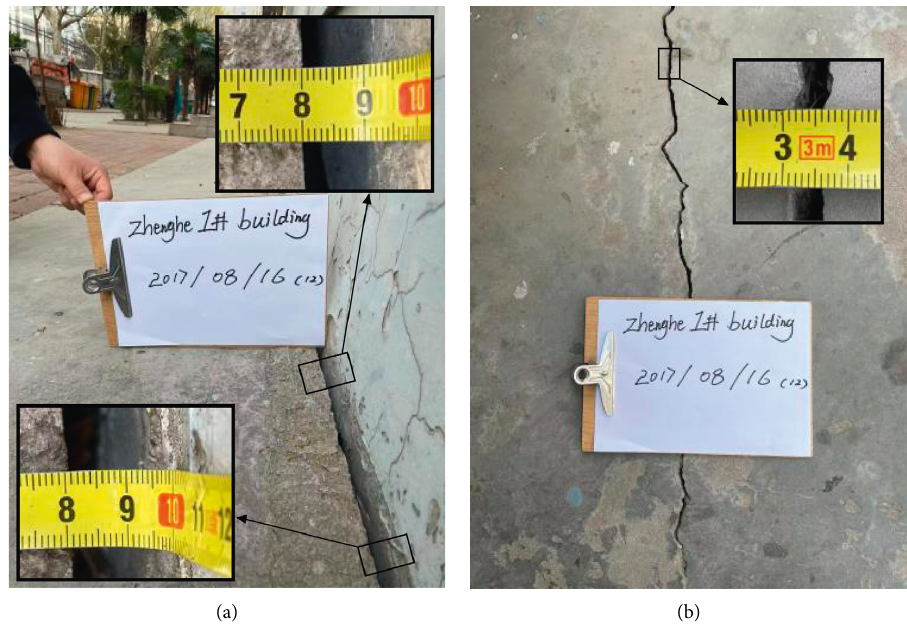
Figure 14: Cracks (a) between the wall and outside apron slope and (b) on the basement floor.